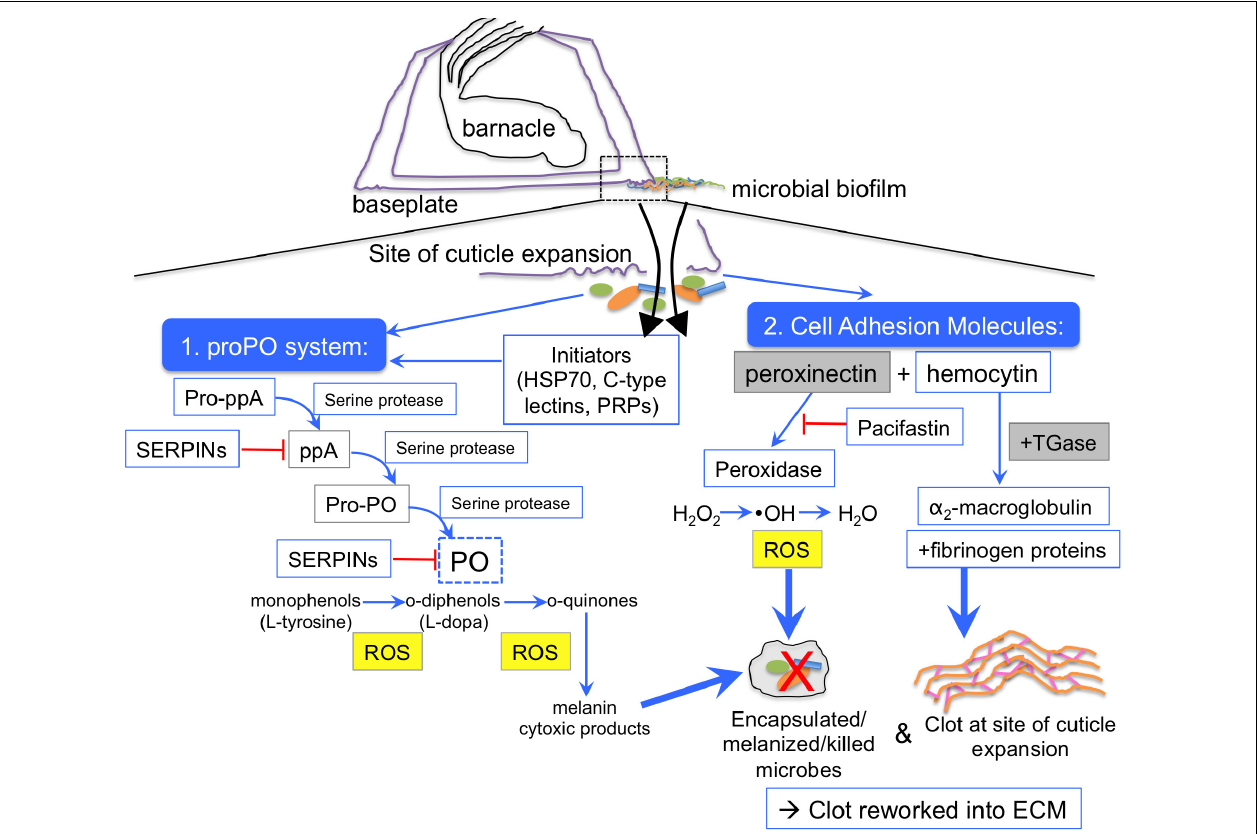
FIGURE 5 | Emerging hypothesis of barnacle glue coagulation scheme mediated by the prophenoloxidase cascade. During barnacle growth cuticle is extended at the outer edge of the base over a biofilmed surface (dotted box). As the cuticle stretches (purple), there are tears, which release fluids (black arrows) that come into contact with microorganisms (orange/green/blue shapes), which present microbe-associated molecular patterns (MAMPs) to the host innate immune system. Two main clotting and defense responses are initiated, one mediated by the prophenoloxidase system (proPO) and one mediated by peroxinectin. ProPO can be activated by initiator proteins like C-type lectins and heat shock protein 70, and other pattern recognition proteins (PRPs) that recognize MAMPs, like endoglucanase. Activation of the phenoloxidase system is initiated via prophenoloxidase activating factor/enzyme (pro-ppA) and mediated by zymogen activation via serine proteases. After the activation of pro-ppA, intermediates like phenoloxidase activating enzyme (ppA), and prophenoloxidase (PPO) are cleaved until finally phenoloxidase (PO) is freed to act on monophenol and diphenol substrates. Serine protease inhibitors (SERPINs), including pacifastin, inhibit (red line) the action of serine proteases at any step of the cascade. Reactive oxygen species (ROS), quinones, and cytotoxic intermediates can all kill nearby microorganisms via encapsulation, melanization and direct oxidation. A concurrent pathway could occur through activation cell adhesion molecules like peroxinectin, a multifunctional protein with peroxidase activity, which converts hydrogen peroxide to a hydroxyl radical (a reactive oxygen species) that can kill microbes and also converts that to water, thus creating and neutralizing ROS in one enzyme. Peroxinectin and hemocytin can interact with clotting proteins (fibrinogen-like proteins) and the crosslinking enzyme transglutaminase (TGase), which crosslinks proteins. Transglutaminase also may act on α -2 macroglobulin, incorporating it into the clot to inhibit bacterial proteases. A crustacean serine protease inhibitor, Pacifastin, stops the phenoloxidase-like activity of peroxinectin (red line). Blue boxes indicate proteins identified through proteomics in this study, dotted blue box indicates confirmation through enzyme assays of this study, the yellow-filled gray box has been shown through microscopy of previous studies (Essock-Burns et al., 2017; So et al., 2017), and gray boxes indicate suspected proteins based on previous work, such